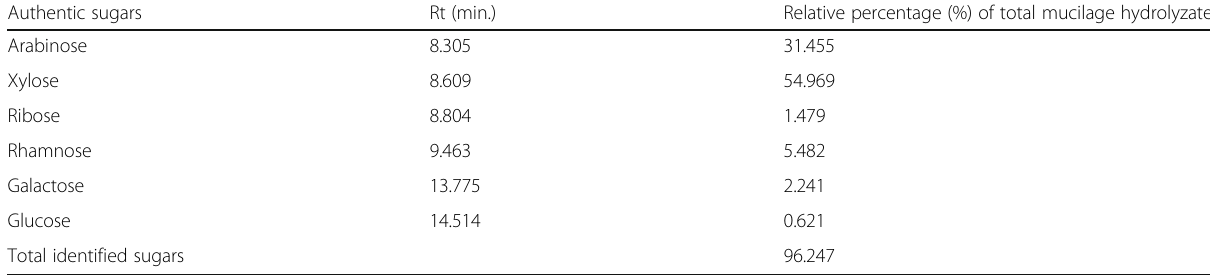
Table 2 GLC analysis of mucilage hydrolysate in the aqueous extract of P . ovata seeds Authentic